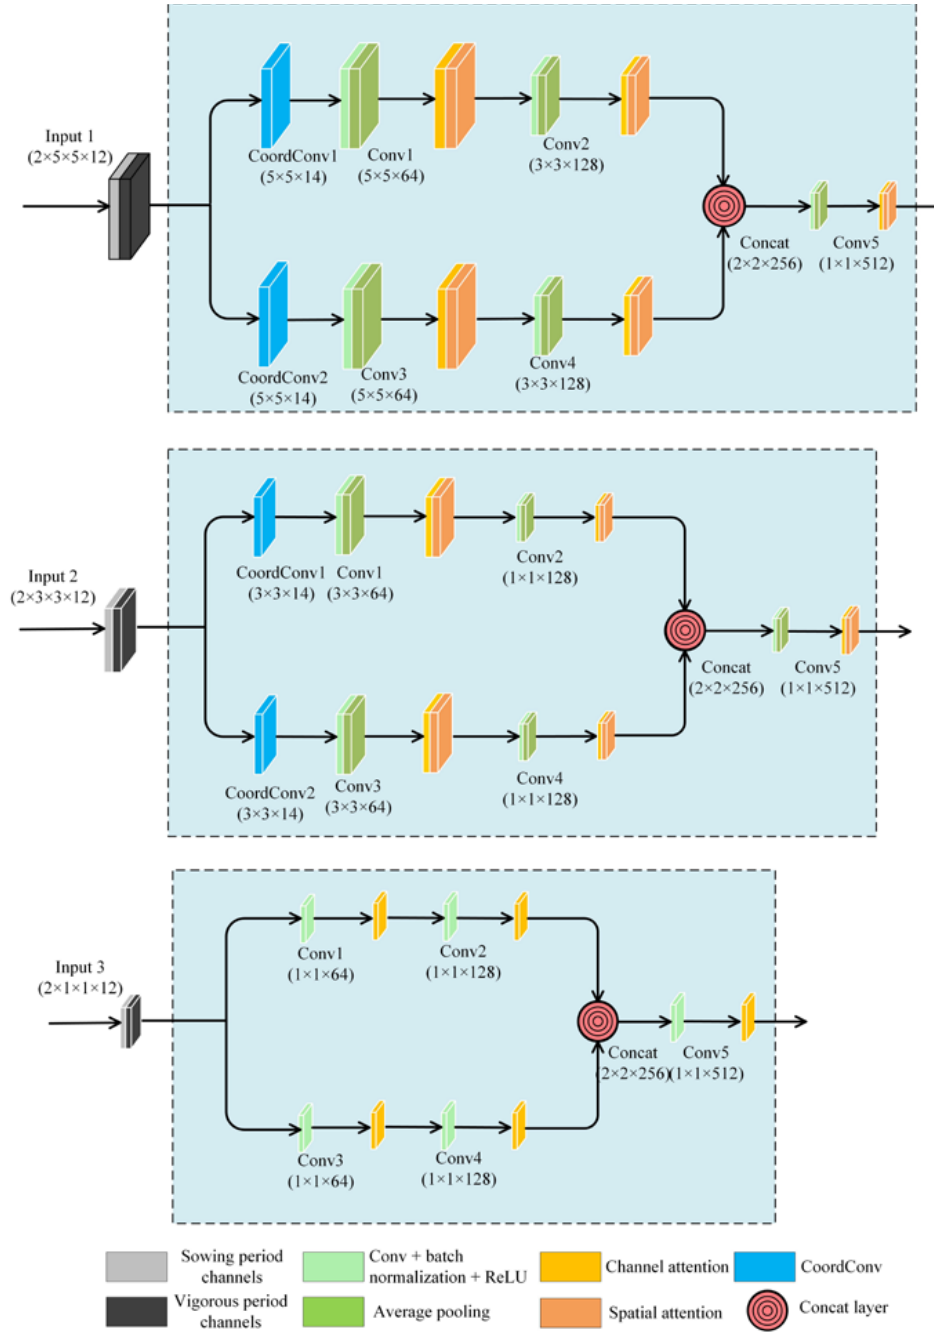
Figure 4. The different network branches within the MACN.